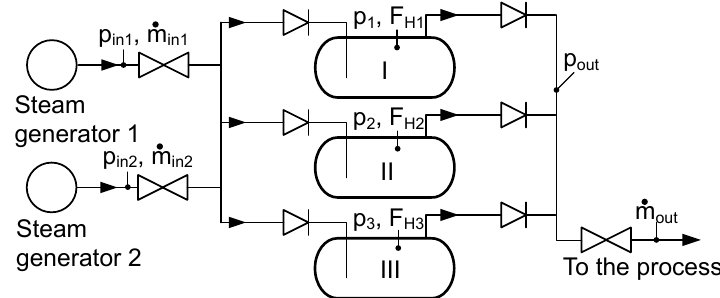
Figure 6. Sketch of the storage line containing three RSS vessels: pressure inside the steam generators p in 1 , p in 2 ; charging steam flow from the steam generators ˙ m in 1 , ˙ m in 2 ; pressure inside the pressure vessels p 1 , p 2 , p 3 ; filling height inside the pressure vessels F H 1 , F H 2 , F H 3 ; pressure inside the discharging collecting pipe p out ; discharging steam mass flow measured after the discharging valve ˙ m out .